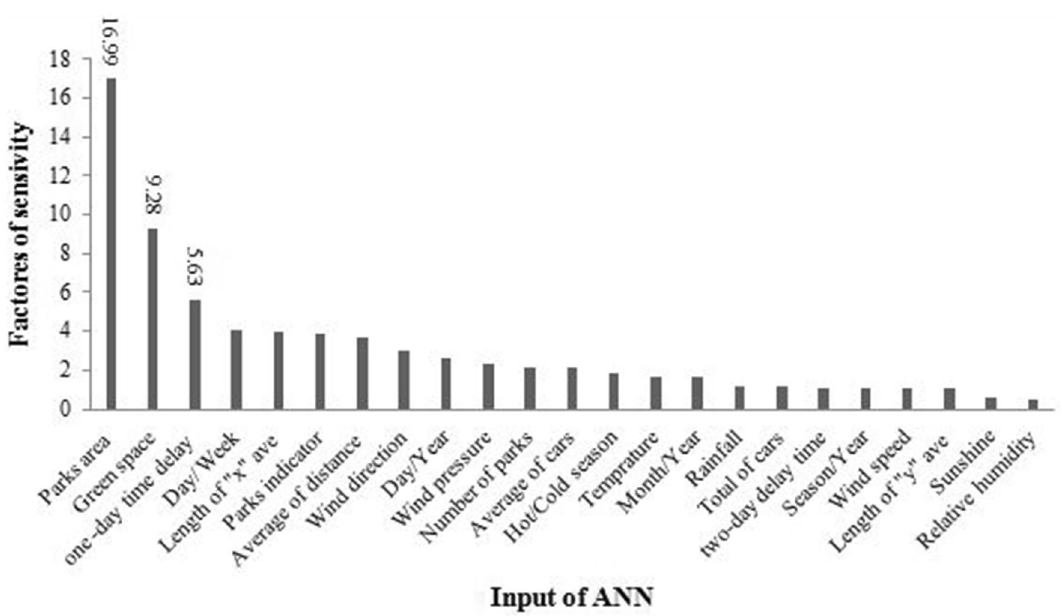
Figure 3. Sensitivity analysis of affecting parameters on NO 2